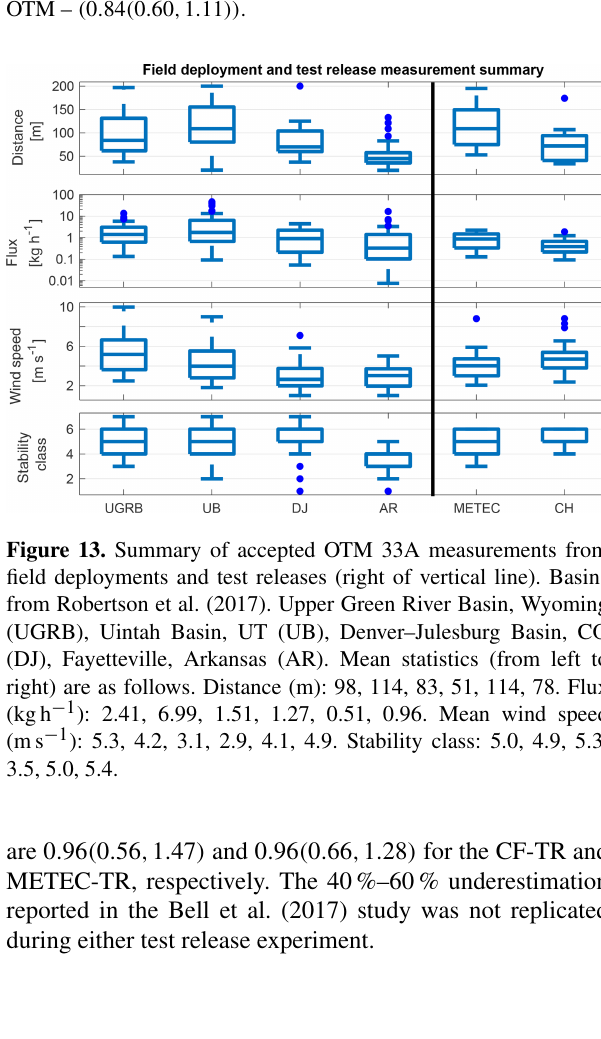
are 0 . 96 ( 0 . 56 , 1 . 47 ) and 0 . 96 ( 0 . 66 , 1 . 28 ) for the CF-TR